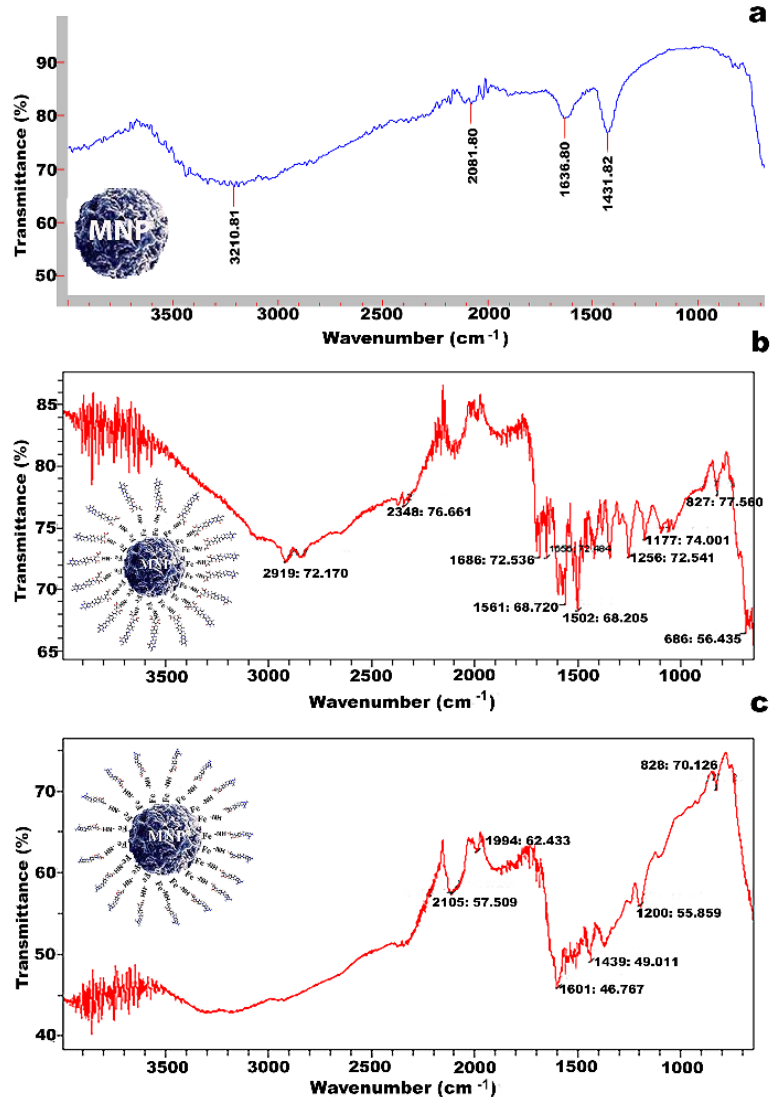
Figure 3. Models and FTIR spectra of MNPs with MTX and MNPs with folic acid. ( a ) FTIR spectrum shows the spinal structure of MNP with associated peaks. ( b ). FTIR spectra of MNP-MTX confirmed the conjugation of MTX on MNP. ( c ) Successful conjugation of MNPs with